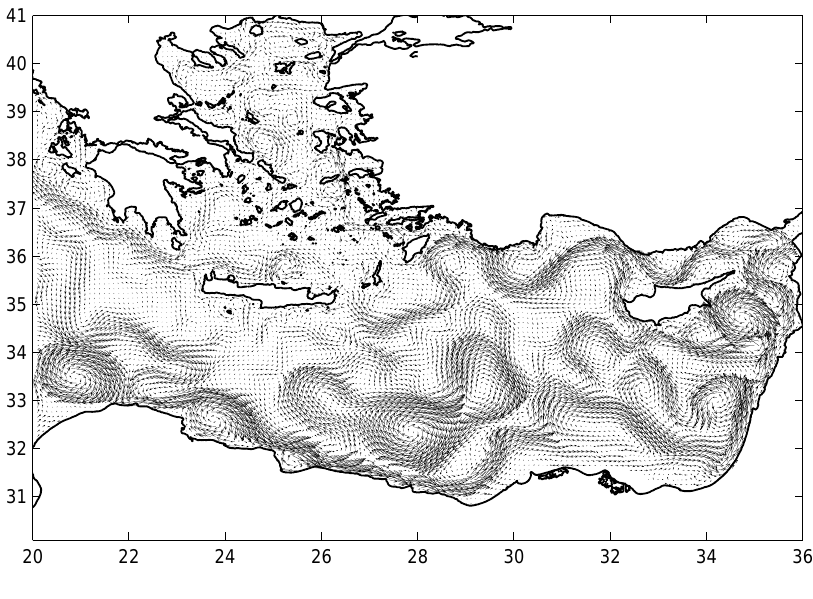
Fig. 6. ALERMO circulation at 30m, for August of the second year of the cli- matological